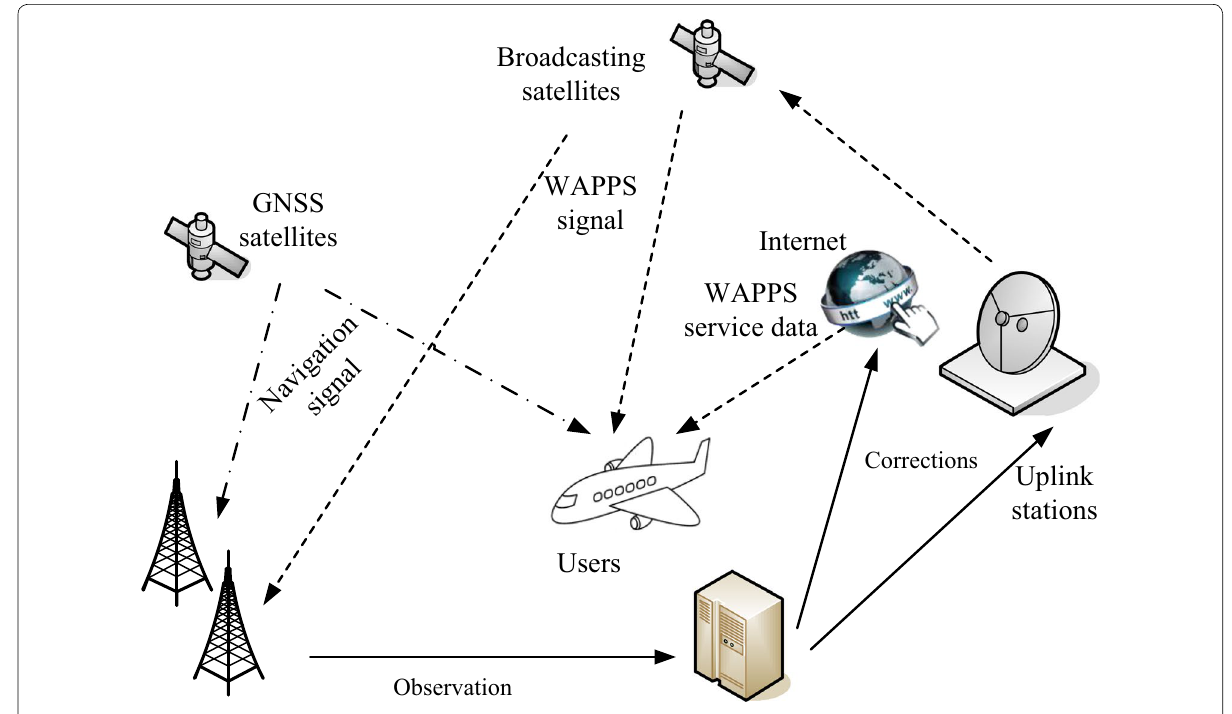
Fig. 6 Demonstration of the WAPPS operating